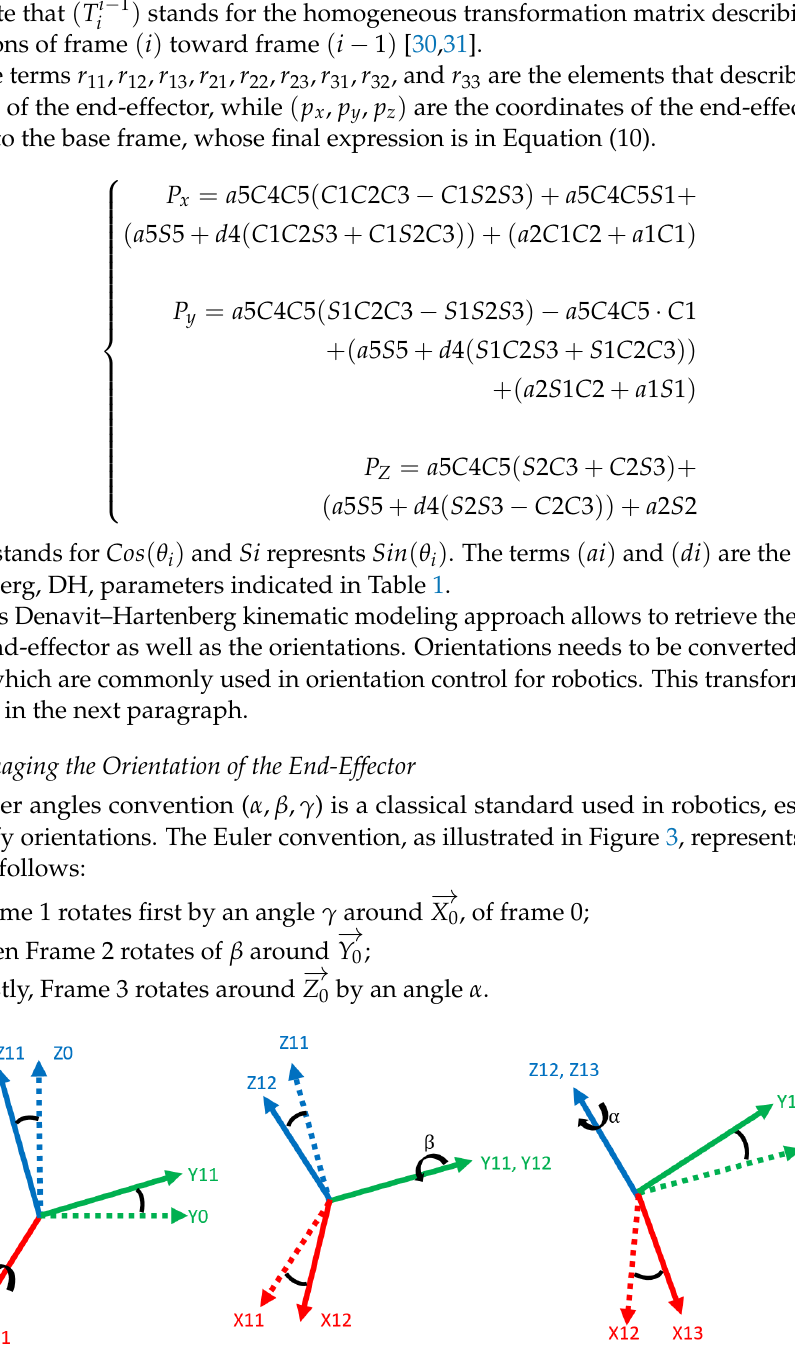
Figure 3. Euler convention rotations R X ( γ ) , R Y ( β ) and R Z ( α )